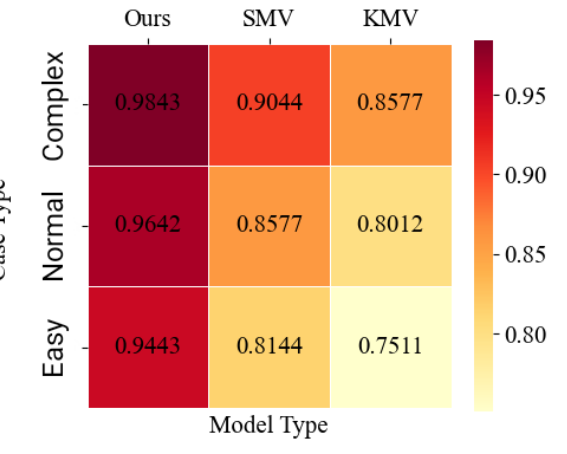
Figure 7. In the same data set, the prediction accuracy of three different models contrasted with data of varying complexity.